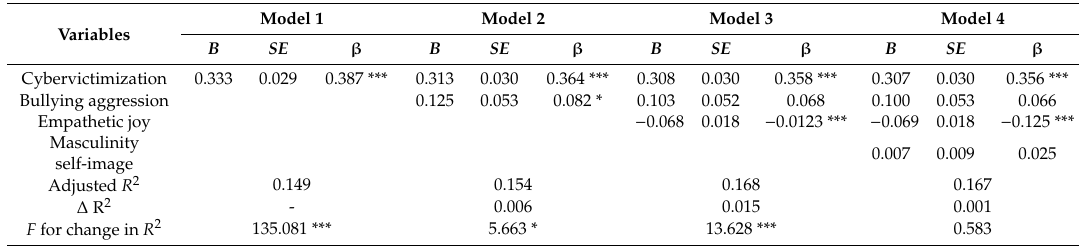
Table 4. Predictor variables of cyberaggression for boys.